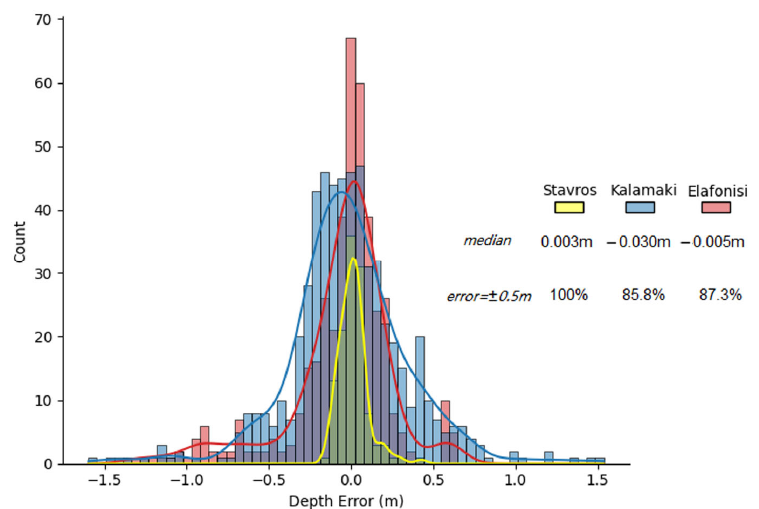
Figure 6. Frequency distribution of residuals (USV depth minus CNN-predicted depth using 60% for training) at each study area and corresponding statistics.